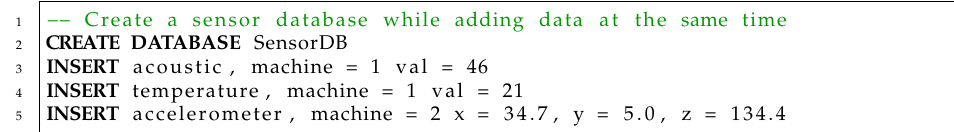
Figure 2. Create a sensor database in InfluxDB.